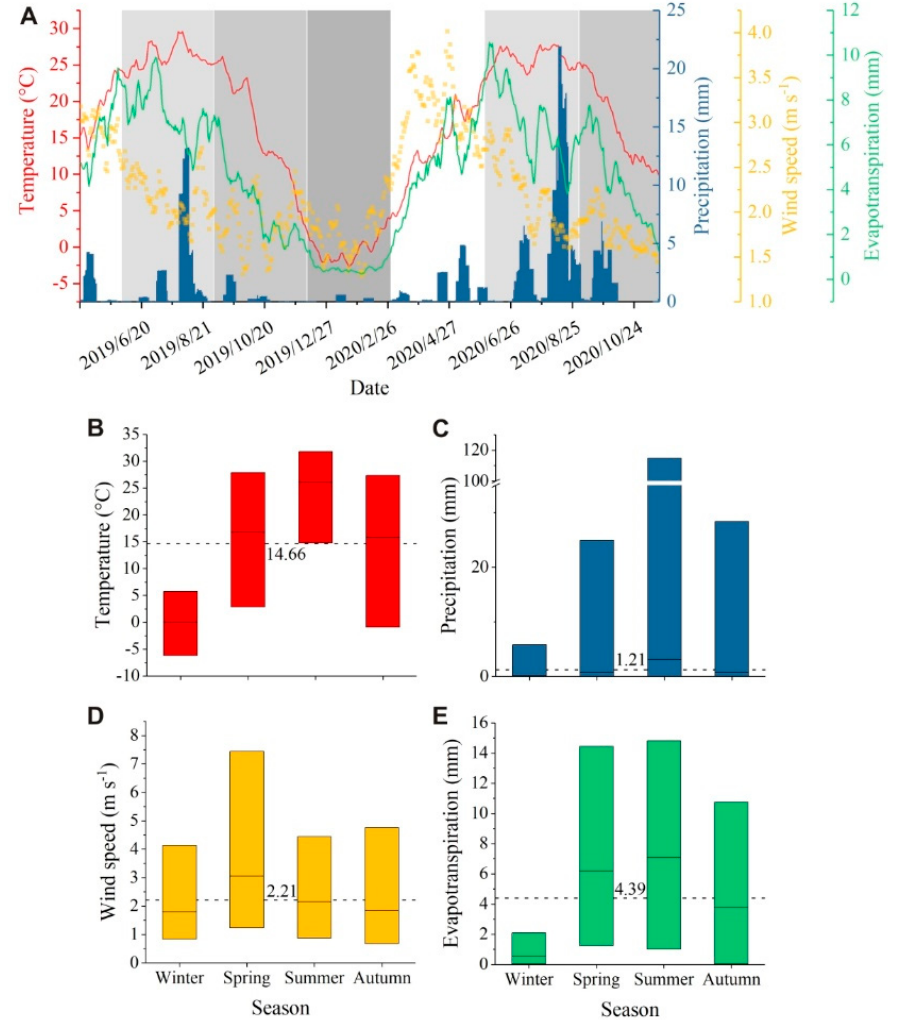
Figure 3. ( A ) Meteorological conditions, and its seasonal ranges for ( B ) the air temperature, ( C ) pre- cipitation, ( D ) wind speed, and ( E ) evapotranspiration. The bar colors in ( B – E ) correspond to those in ( A ), the black line in each bar indicates the seasonal average value, and the dotted line across the bars denotes the average value during the monitoring period.